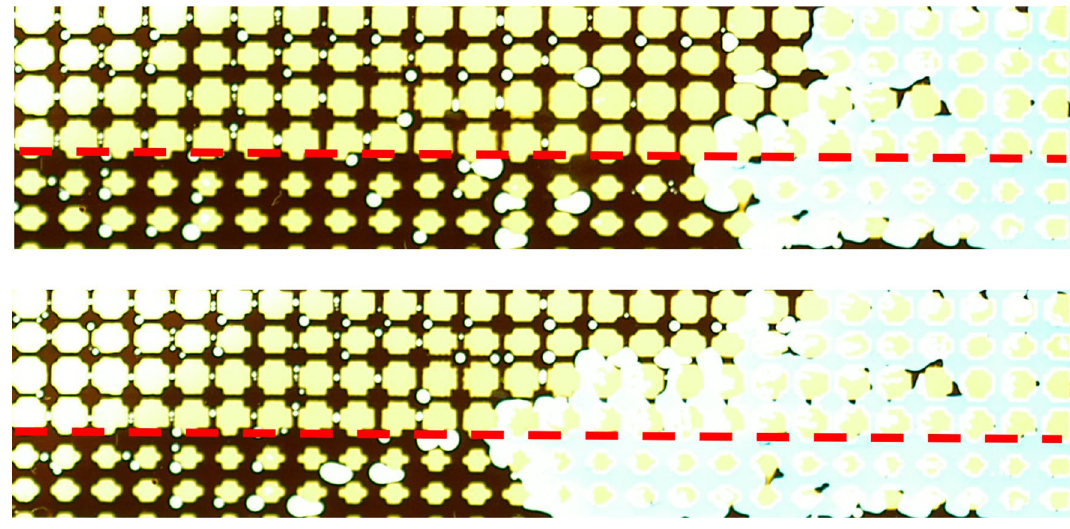
Fig. 10 Polymer front advancement in two-layered heterogeneous flow pattern, injection point on the right, upper side picture after 0.2 PV injected, lower side picture after 0.4 PV injected (brown color is oil, yellow color is grain and whitish blue color is polymer